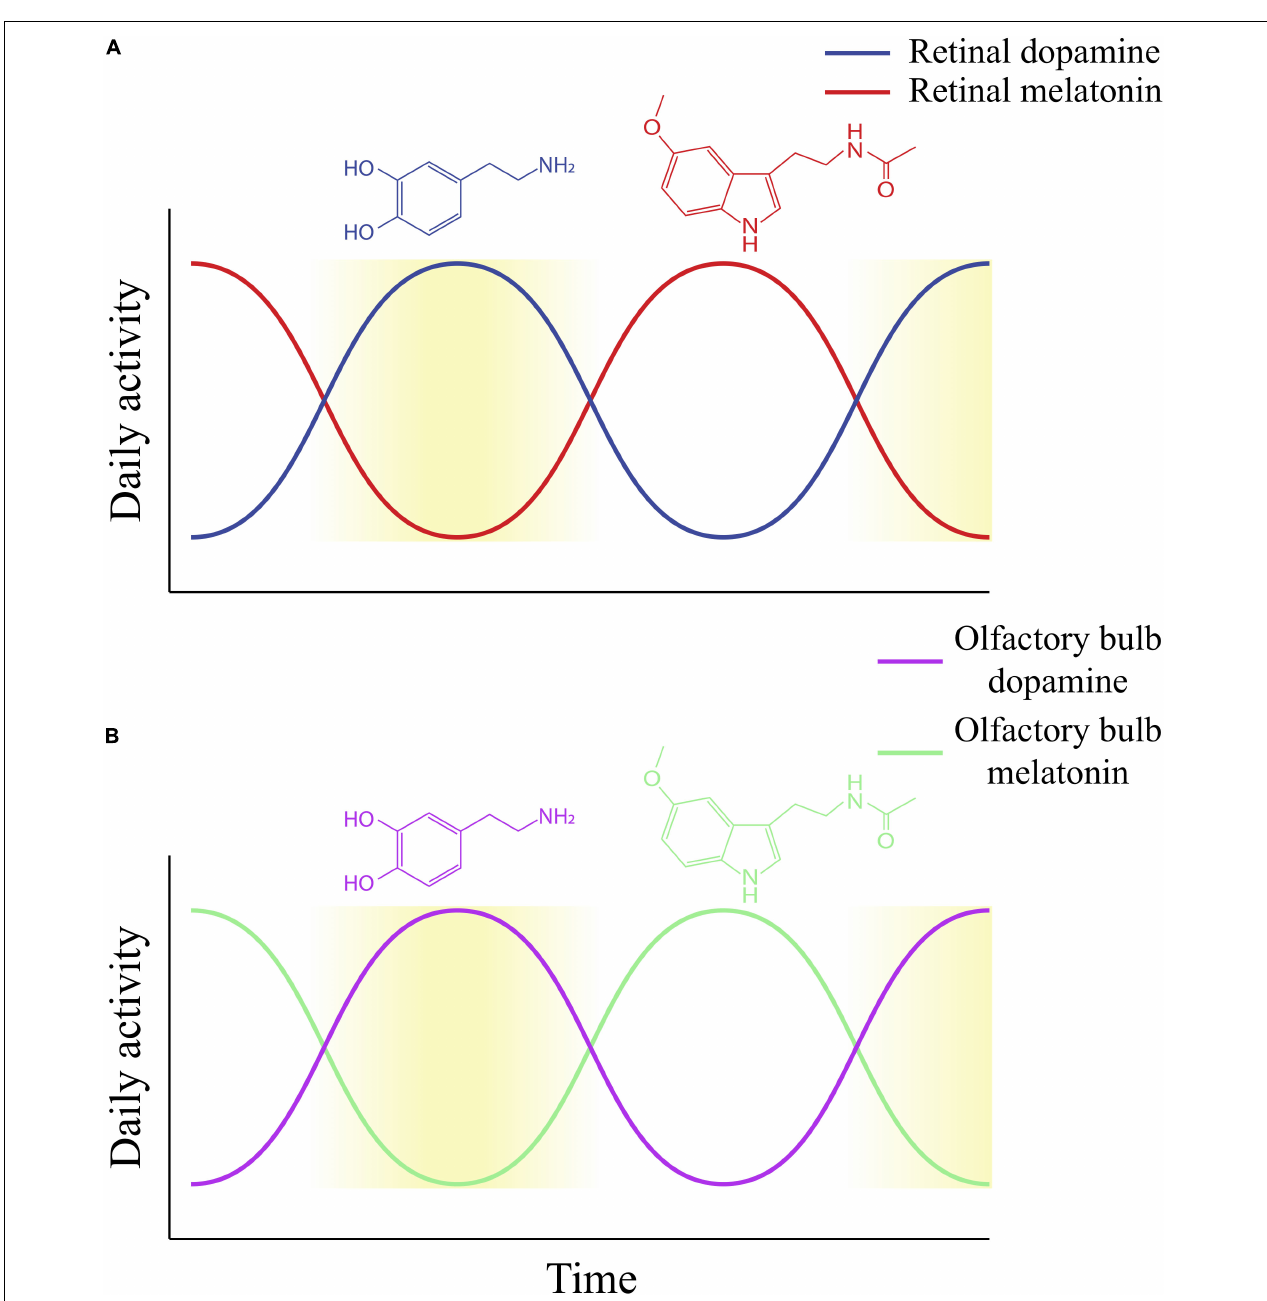
FIGURE 3 | The daily rhythms of dopamine and melatonin activity, as established within the retina (A) and proposed within the olfactory bulb (B) . Increasing yellow gradient indicates an increase in the level of light to which the retina is exposed (A) or is an indicator of the time of day for the olfactory bulb (B) . (A) Retinal dopamine synthesis and activity is highest during daytime, while retinal melatonin activity is highest during nighttime. This figure does not make the distinction between light-driven and circadian dopamine synthesis and release. While both would produce similar rhythms (dopamine is highest during the daytime or subjective day), dopamine release in constant darkness (circadian) would be much lower than light-stimulated dopamine release. (B) The proposed daily rhythm of dopamine in the olfactory bulb based on our prior study on dopamine content and release over 24 h in a12-h light/dark cycle. We found that olfactory bulb dopamine demonstrates diurnal activity, with highest activity occurring when lights are on and lowest levels when lights are off (Corthell et al., 2013). The proposed daily melatonin rhythm in the olfactory bulb is based on our prior determination of levels of mRNA for melatonin synthesizing enzymes in rats exposed to 12-h light/dark cycles. We found that HIOMT mRNA, for example, fluctuates in a diurnal fashion, with the lowest expression during lights-on and highest expression during lights-off (Corthell et al., 2014). Thus, this figure illustrates potential diurnal rhythms of olfactory bulb dopamine and melatonin, which peak in the daytime and nighttime, respectively. However, it has not been determined whether olfactory bulb dopamine and melatonin display circadian rhythms.